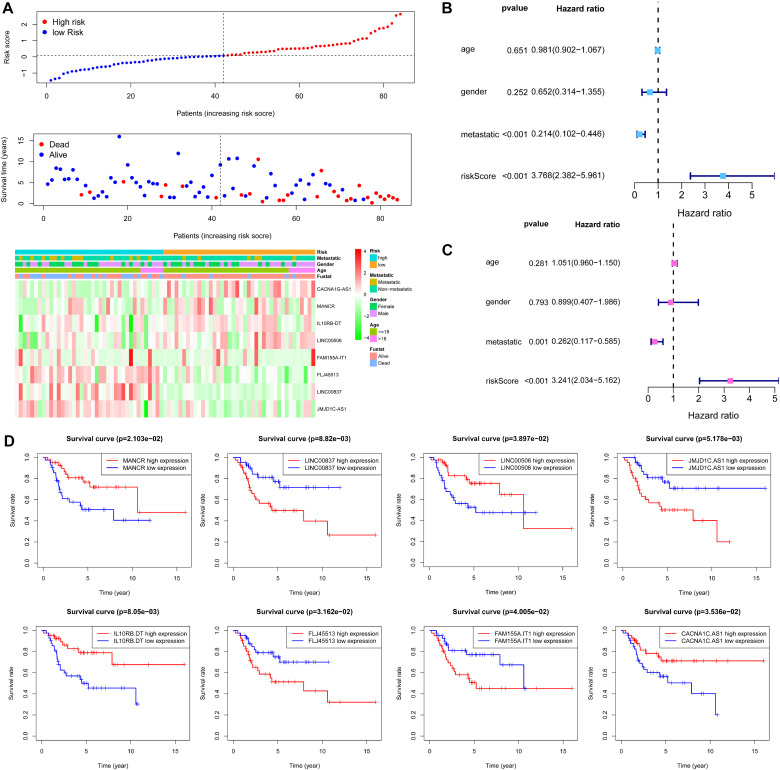
Evaluation of metabolism-related lncRNA signature. (A) Risk score distribution and survival status of OS patients based on the eight metabolism-related lncRNAs and a heat map of the eight metabolism-related lncRNAs expression pattern. (B) Univariate Cox regression analysis showing the metastatic and the eight metabolism-related lncRNA signature risk score were significantly associated with overall survival. (C) Multivariate Cox regression analysis showing that the eight metabolism-related lncRNA signature risk score was an independent prognostic indicator for overall survival of OS patients. (D) Kaplan–Meier curves showing that the expression of the eight metabolism-related lncRNA had different overall survival for OS patients.